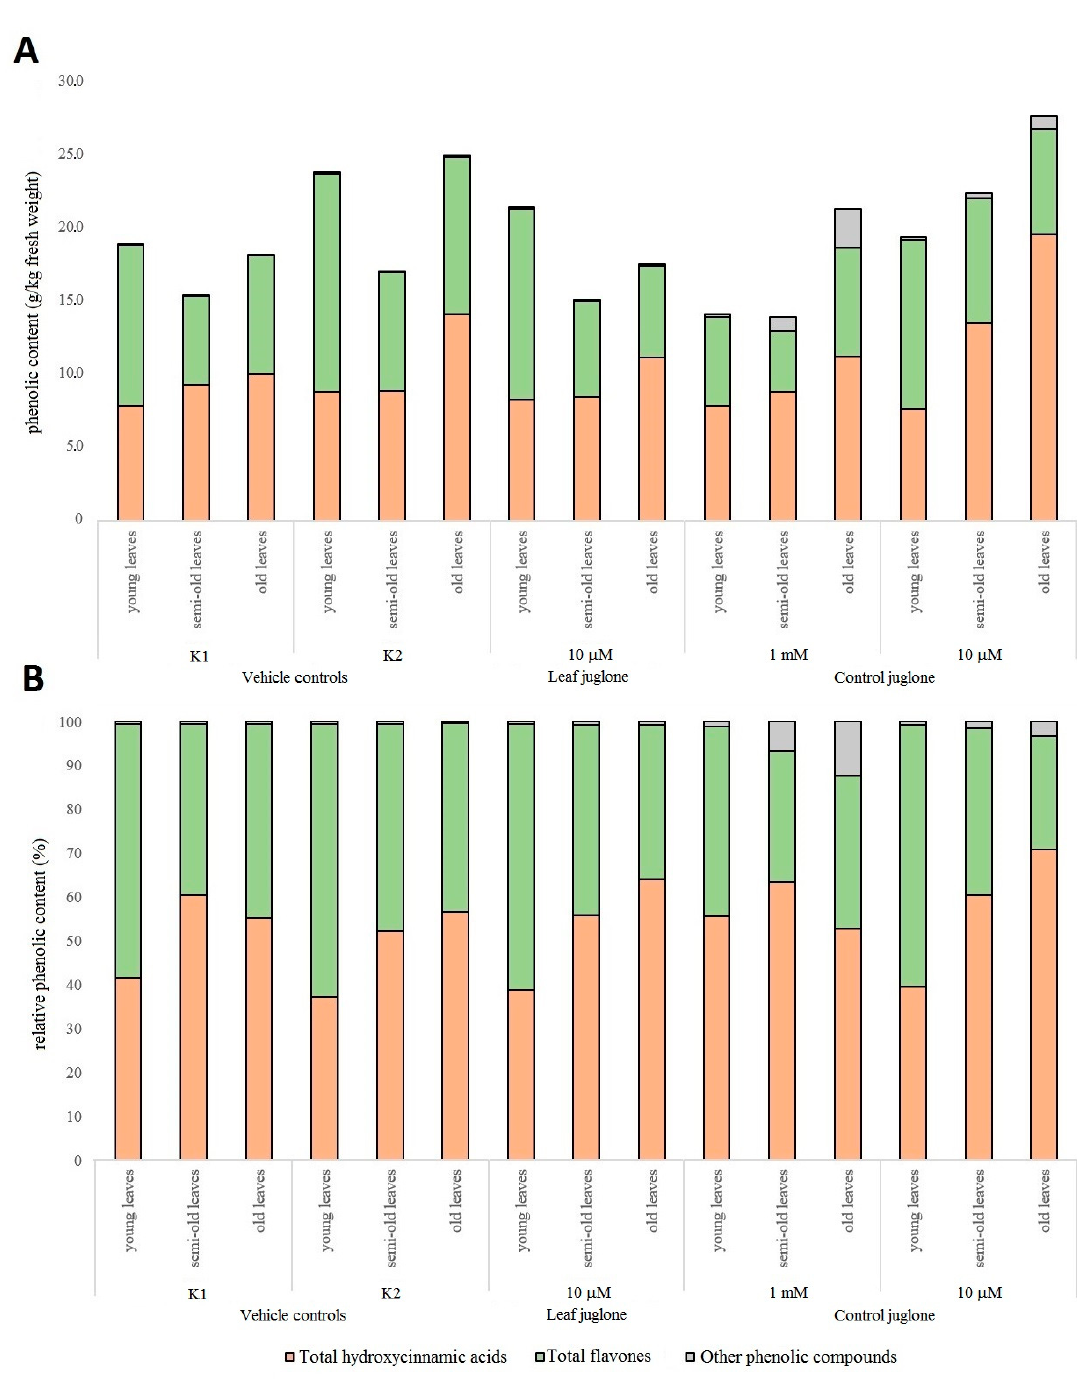
Figure 5. Contents of the total phenolic groups identified in V. locusta expressed relative to fresh weight ( A ) and as proportions of the total phenolic groups identified ( B ). K1: extraction medium control (0.17% DMSO, 0.17% ethanol in H 2 O); K2: water control. Young leaves, undeveloped leaves; semi-old leaves, remaining fully developed leaves; old leaves, four outer fully developed leaves.